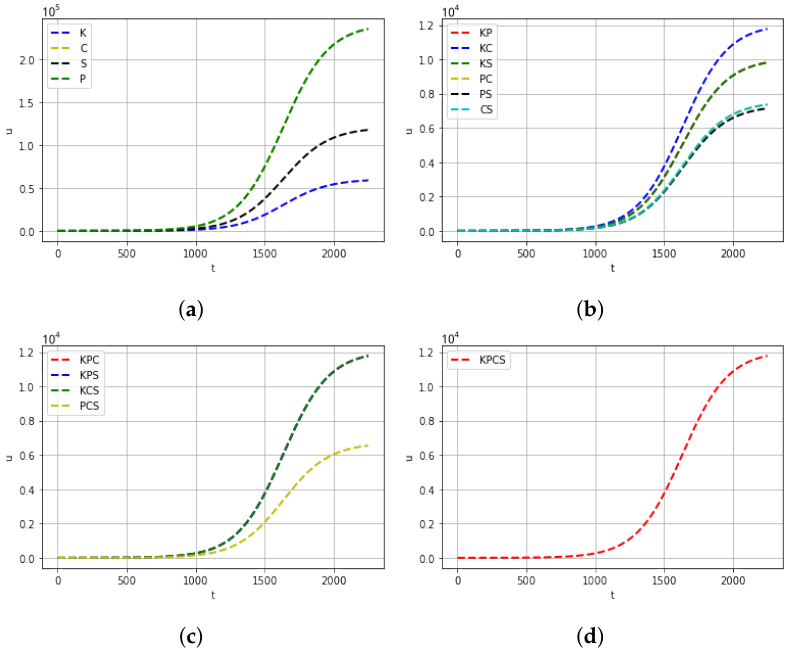
Figure 4. Dynamics of the populations of cancerous and precancerous cells, taking into account the impact of effector CTLs of the immune system. ( a ) One-mutation cells, ( b ) two-mutation cells, ( c ) three-mutation cells, ( d ) KPCS